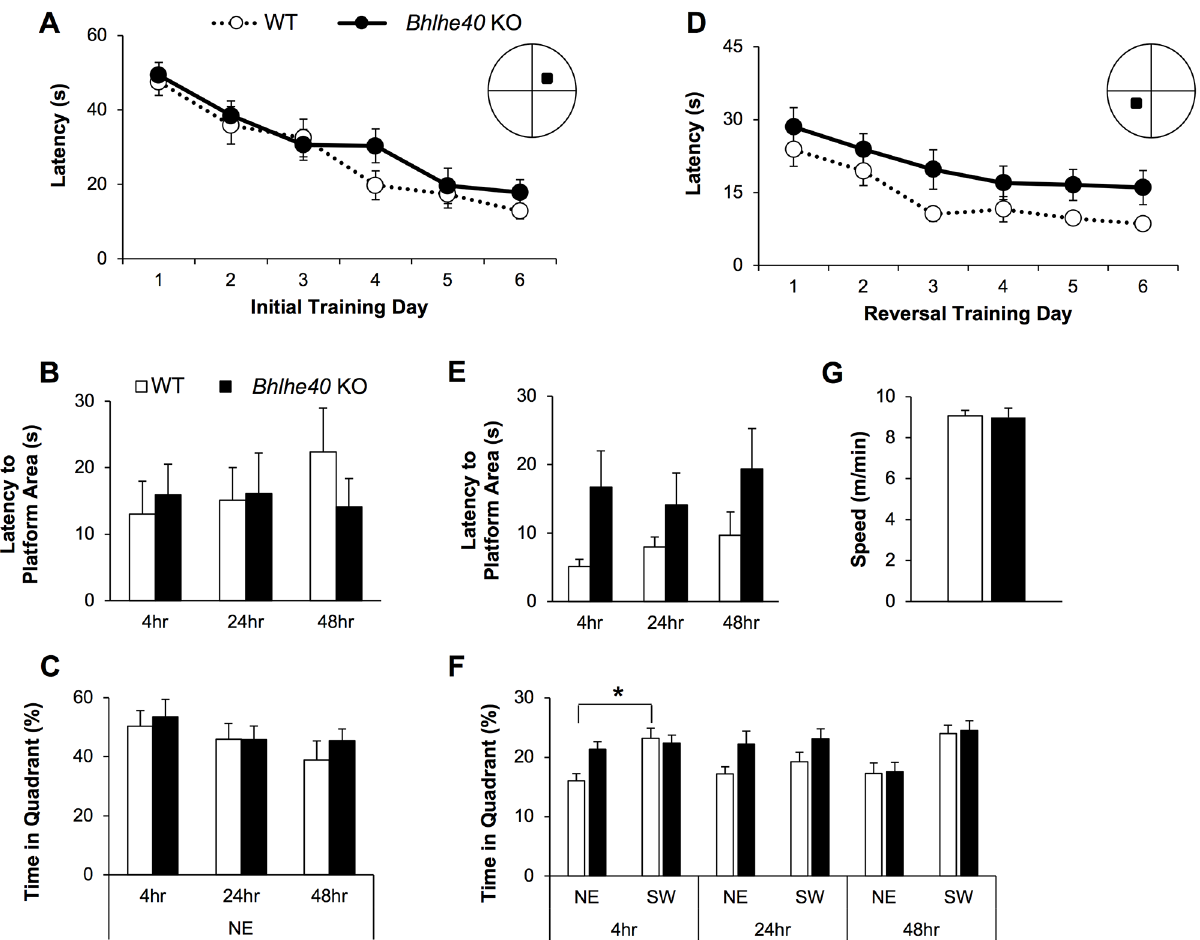
Fig 4. Bhlhe40 KO mice have impaired relearning on the MWM. (A) There was no change in escape latency during initial learning and (B) initial probes revealed no cognitive deficits of Bhlhe40 KO animals as indicated by latency to platform. (C)or time spent in the goal (NE) quadrant. (D) Bhlhe40 KO mice had impaired relearning of the new platform location (SW quadrant) (linear regression line elevation difference p < 0.01) (two-way RM-ANOVA p = 0.067). (E) Similarly, Bhlhe40 KO animals were impaired in the latency to the new platform area on the reversal probes (linear regression line elevation difference p < 0.05 t-test) (two-way RM-ANVOA p = 0.059). (F) On the 4hr reversal probe Bhlhe40 KO showed no preference for the new platform location (SW) quadrant compared to the initial platform location (NE) quadrant, whereas WT animals spent more time in the NE compared to SW quadrants (p < 0.05). (G) There was no significant difference in time spent in the SW quadrant compared to the NE quadrant for either Bhlhe40 KO or WT animals on the 24hr and 48hr reversal probes (p > 0.05), although there was a near-significant trend for WT animals on the 48hr probe (p = 0.0531). Across all conditions there was no effect on swim speed (p > 0.05) WT n = 12, Bhlhe40 KO n = 12. Initial 24hr probe measurements included only n = 11 for Bhlhe40 KO mice due to a software error in recording one animal. One Bhlhe40 KO animal was removed from the dataset due to repeated thigmotaxis-like behavior. Error bars are standard error of the mean. Statistical significance ( (cid:3) p < 0.05) was tested by two-way RM-ANOVA (Figs 4A, 4B, 4C, 4D, 4E, and 4F), comparison of linear regression lines (Figs 4A, 4B, 4D, and 4E) and Mann Whitney U test (Figs 4E, 4F, and